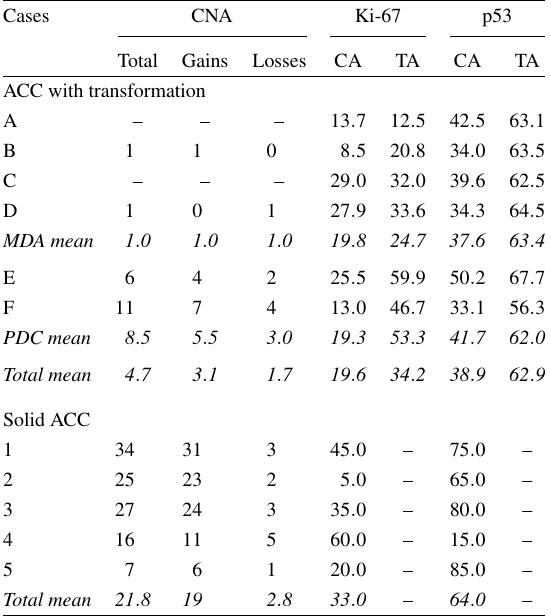
Summary of microarray CGH and Ki-67